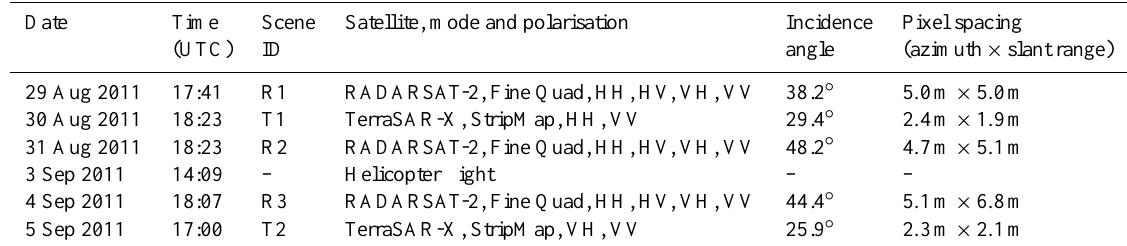
Figure 1. Map of the western Fram Strait showing the location of the satellite scenes included in the study and the track of the helicopter flight collecting airborne measurements for the study. The red box in the inset map of the Northern Hemisphere displays the geographical position of the area displayed. At the time of the flight, R/V Lance was slightly north of this map section. Table 1. Overview of the data